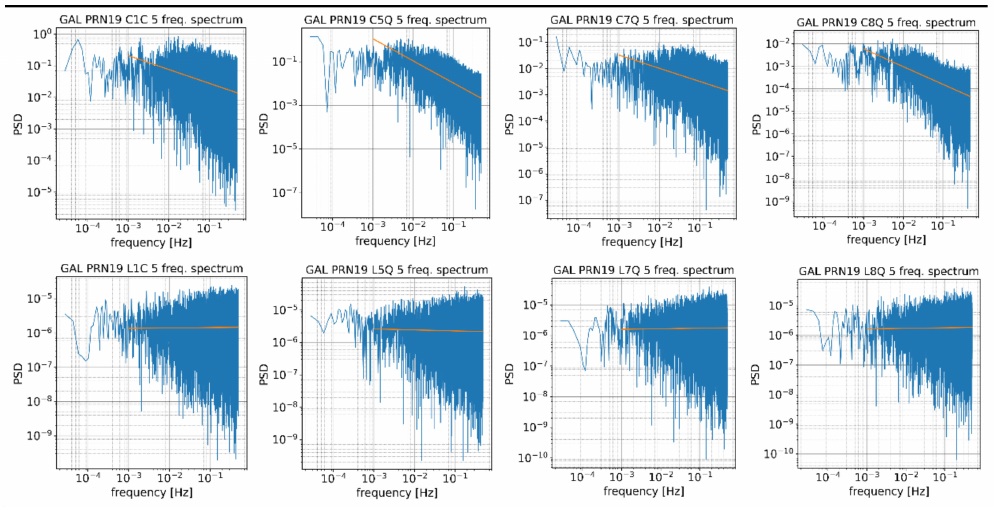
Figure 10. Lomb–Scargle periodograms for Galileo PRN19 satellite. Orange lines represent the line fitted in the part of the spectrum in the range of 0.001–0.5 Hz. The slope of the line represents the spectral index